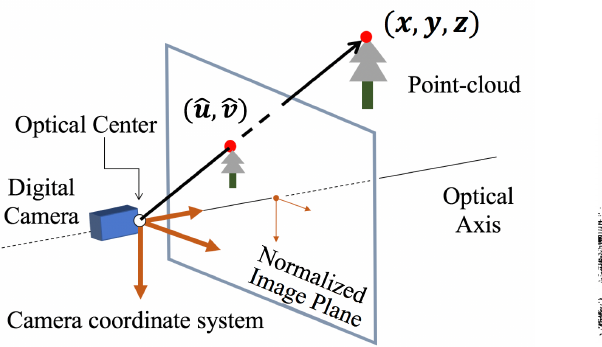
Figure 10. Removal of planes, cylinders, and lower